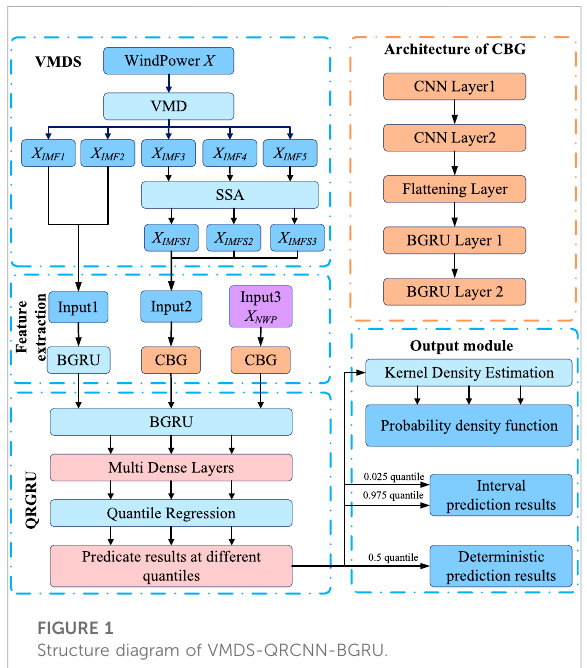
FIGURE 1 Structure diagram of